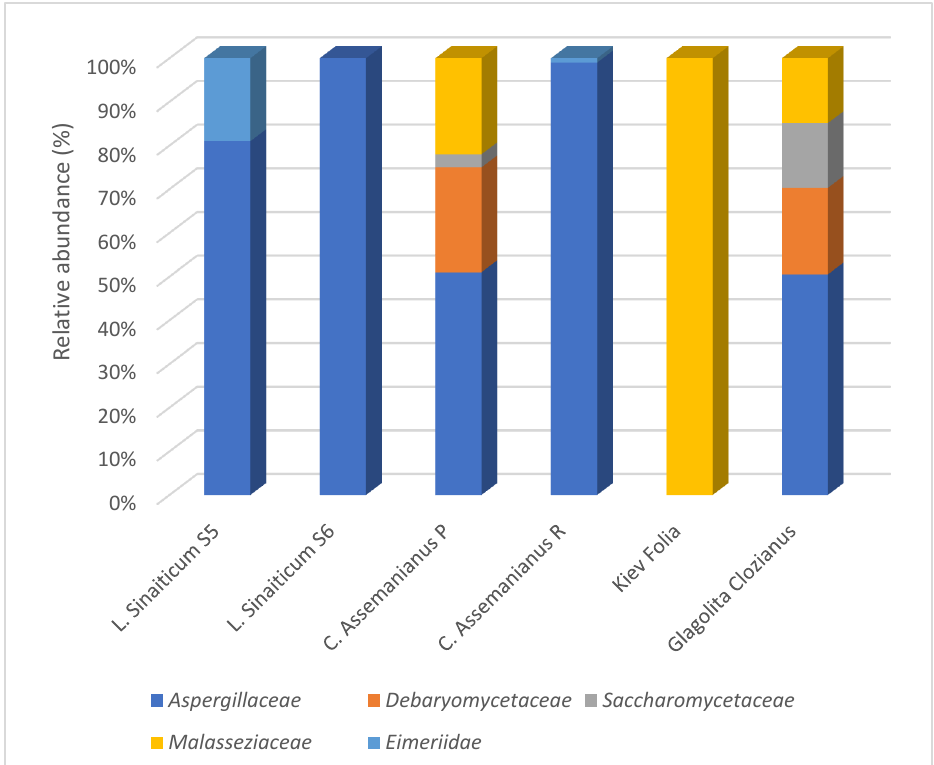
Figure 8. Shotgun metagenomics showing the relative abundance (%) of eukaryotes in the micro- biomes of ancient Slavonic codices at the family level [3,8] (and in Glagolita Clozianus in this study). The overall relative abundances of the eukaryotes in the microbiomes were: L. Sinaiticum S5: <1%; L. Sinaiticum S6: <1%; C. Assemanianus P: 1.5%; C. Assemanianus R:1.2%; Kiev Folia : <1%; Glagolita Clozianus : <1% (This